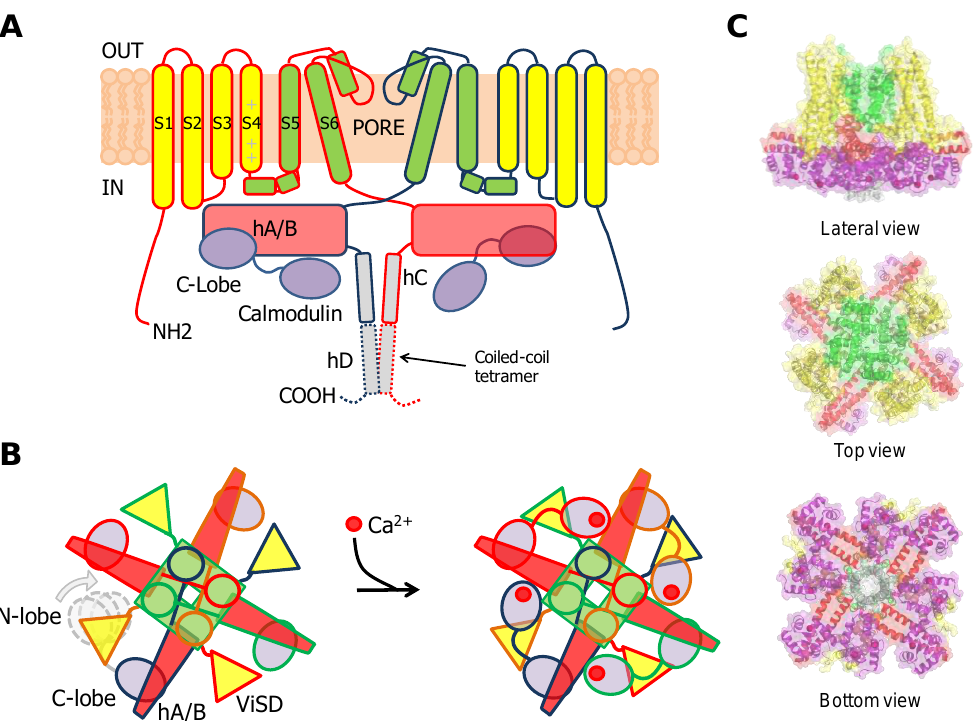
Figure 4. Representation of SK channels . ( A ). Transmembrane regions are in yellow for the Voltage inSensitive Domain (ViSD), green for the PD and calmodulin in purple. Helices A and B are colored in red and run parallel to the membrane under the diametrically placed subunit. The presumed position of the tetrameric coiled-coil is indicated with dashed lines. Only two of the four subunits are represented, with a red or blue border. ( B ). Realistic representation of the channel view from the top using the same color scheme as in A. Each subunit has a di ff erent color. On the left, under resting conditions the N-lobe (dashes lines) wanders around and occasionally enters into the space underneath the subunit next to the C-lobe docking site, with three preferred positions. On the right, upon Ca 2 + loading (red circle) the N-lobe docks into and makes contact with three di ff erent subunits. ( C ). Structures visualized using then PDB coordinates (6CNO), rendered with Pymol 1.30 using the same color scheme as in panel A.